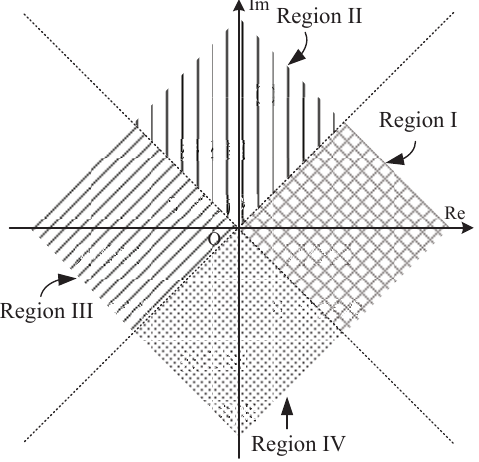
Figure 2. Division of the complex observation